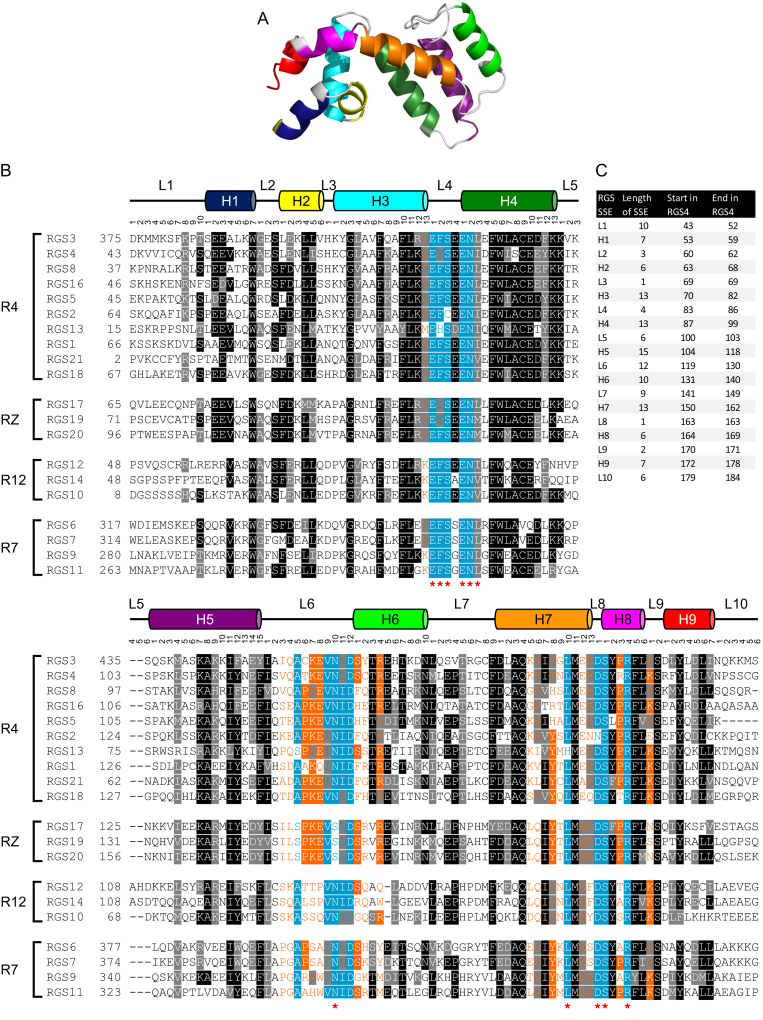
The Common RGS Numbering (CRN) System, Related to Figure 5(A) The structure of the RGS4 RGS domain with color-code for each helix. (B) The alignment of all human RGS paralogs with CRN. The common residue numbers are shown on top of the alignment. Directly contacting residues based on the structure of the RGS4/Gαi1 complex are highlighted with red asterisks at the bottom of the alignment. The gray indicates the residues with conserved property and black indicate the conserved residues. Of note, there are two insertion/deletion regions in this alignment of the RGS domain. First, there are four amino acid residues in loop 5 in the most of RGS proteins. Instead, there are six amino acids in RGS12 and RGS14, but only three amino acid residues in all R7 RGS members in this structural element. Second, all three R12 RGS proteins are missing an amino acid residue in the H6 region. It is not possible based on existing structural alignments to say where this gap actually occurs, because the H6 region is conformationally heterogeneous in R12 structures and cannot be structurally aligned with other RGS proteins other than to say it has helical character as detected by NMR. The disorder of this region in R12 subfamily members has in fact been proposed to play a role in selecting against the Gαq family due to loss of beneficial interactions with SwIII (Taylor et al., 2016) The conserved and selectivity residues identified by ortholog/paralog analysis (Figure 5C) are highlighted in blue and orange, respectively. The sequence alignments were generated with T-Coffee (http://tcoffee.crg.cat/apps/tcoffee/do:regular) and colored by BoxShade (https://embnet.vital-it.ch/software/BOX_form.html). (C) Reference table of the definitions of the secondary structure elements used in the CRN nomenclature. PDB accession number 1AGR is used in panel (A).